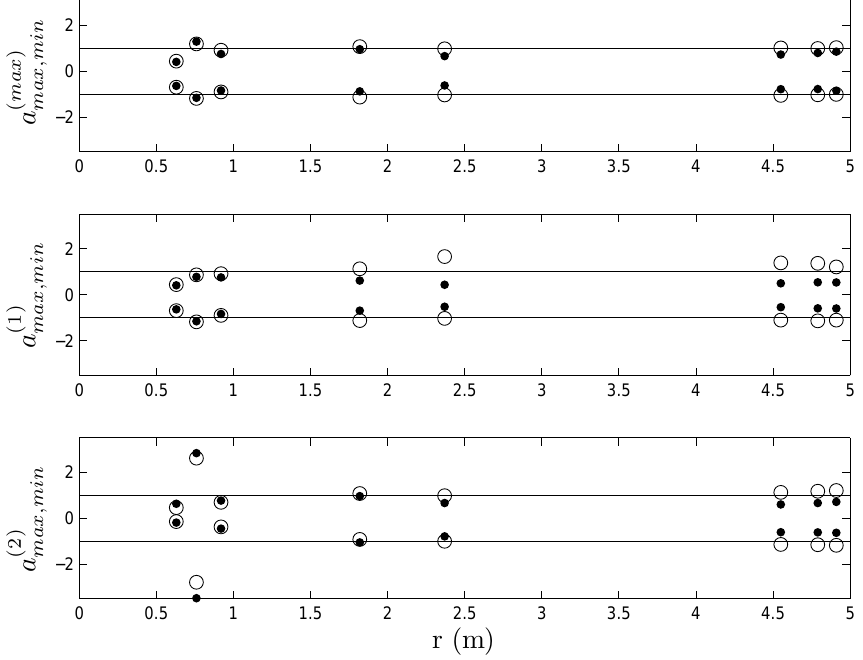
Fig. 5. Free water surface elevation as measured in the laboratory experiments (thick black line), as computed by the numerical model with the proposed source term (thin black line) and as computed with the same numerical model but using the source term proposed by Tinti et al. (2006) (thin red line).